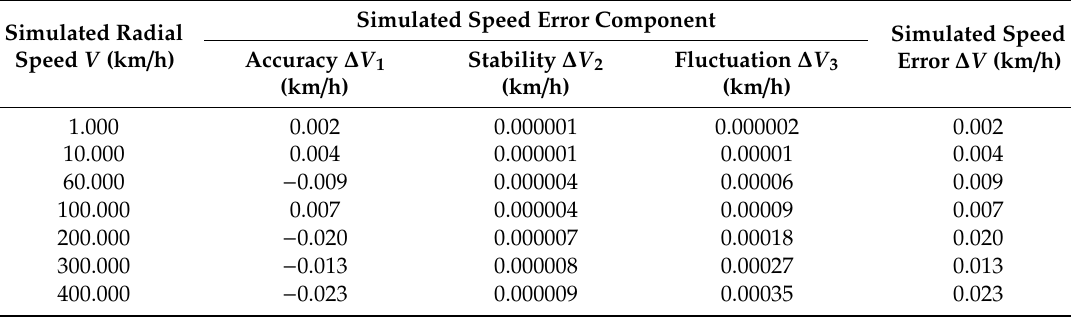
Table 9. Simulated speed error of the second moving target